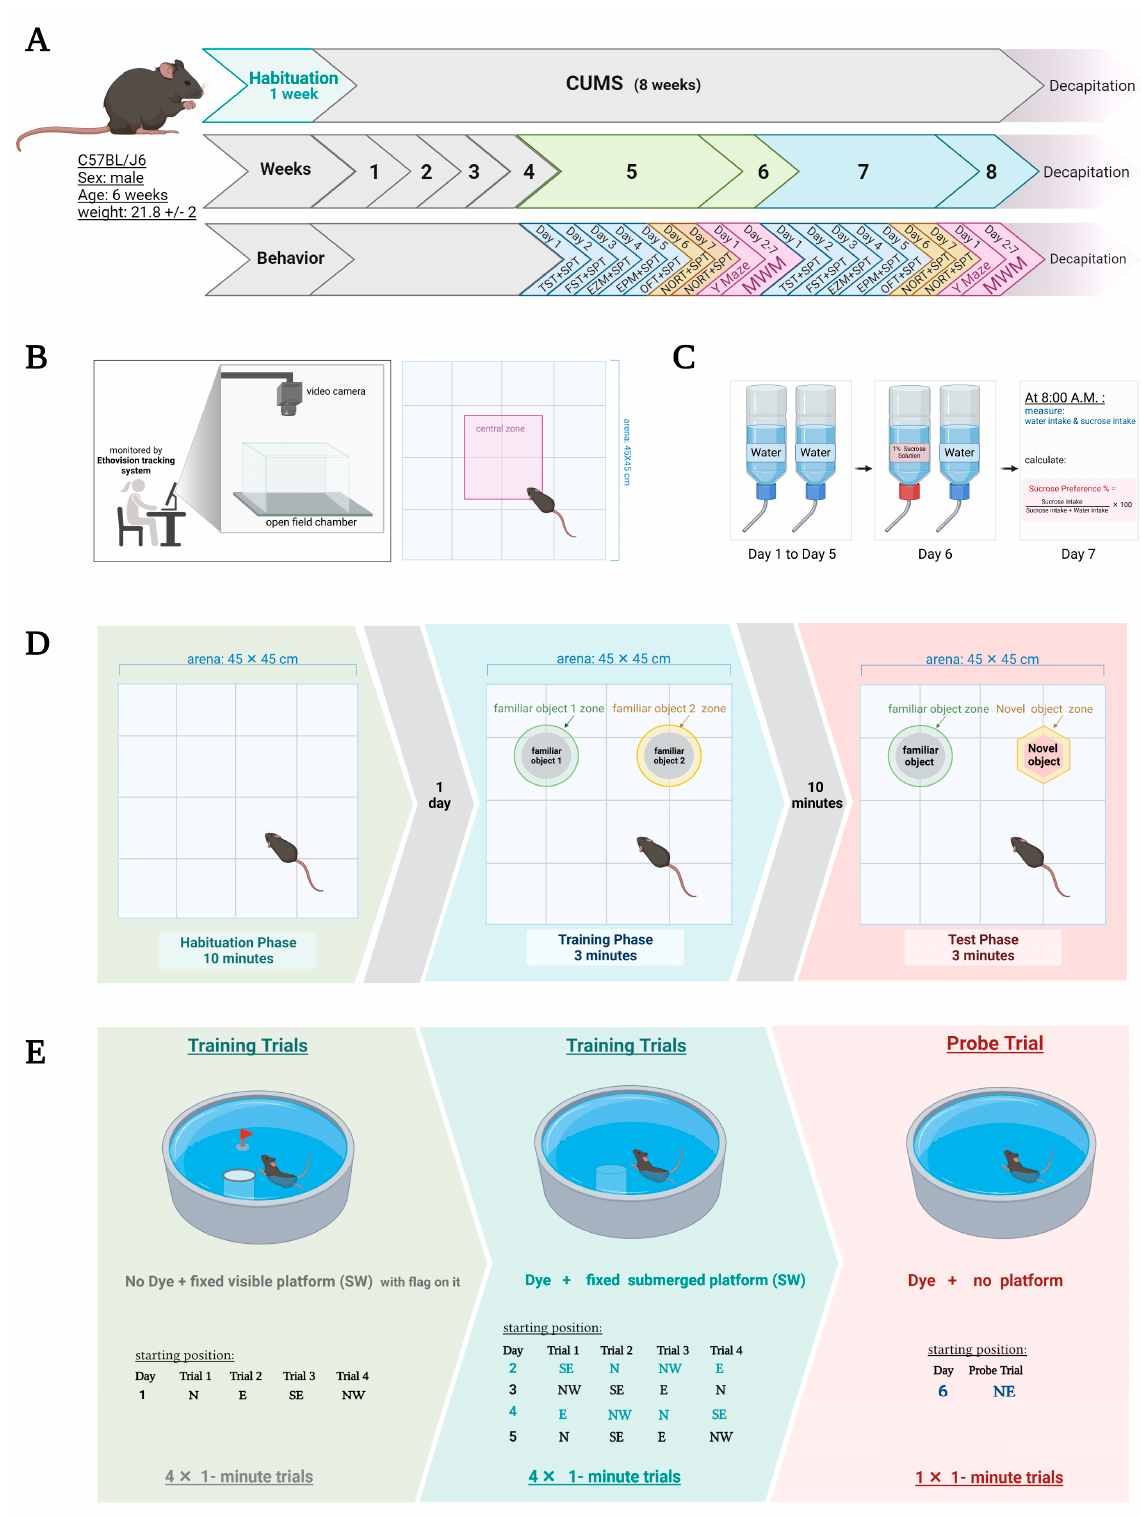
Figure 1. ( A ) Timeline of the experiment with an overview of behavioral tasks. The same behavioral tests were repeated in weeks 5–6 (early CUMS) and 7–8 (late CUMS). ( B ) Schematic representation of OFT under EthoVision tracking system. ( C ) SPT protocol. ( D ) NORT protocol includes 3 stages: habituation, familiarization, and test stages. ( E ) MWM protocol. CUMS: chronic unpredictable mild stress, EPM: elevated plus maze, EZM: elevated zero maze, TST: tail suspension test, FST: forced swimming test, OFT: open field test, SPT: sucrose-preference test, NORT: